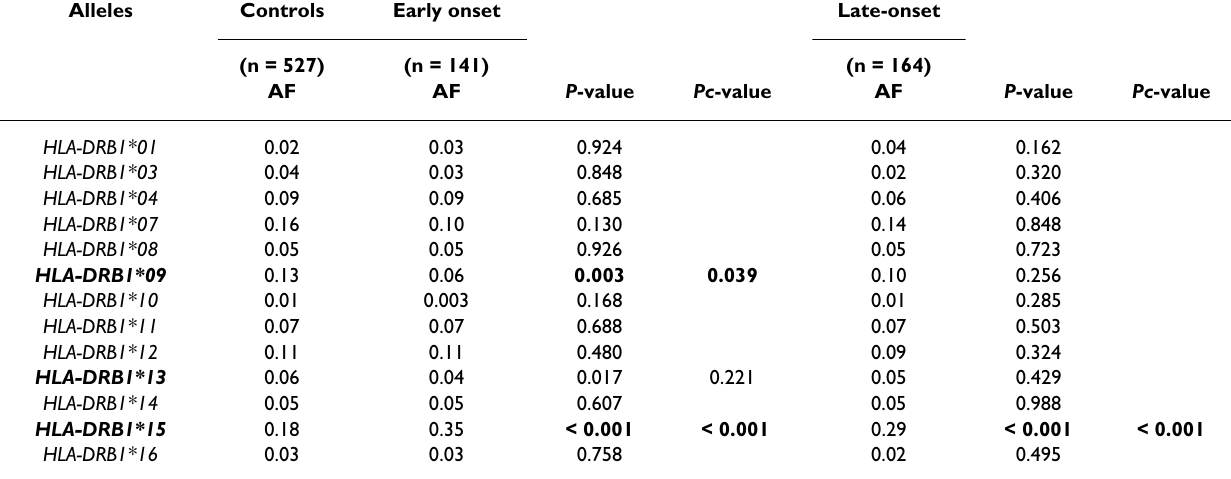
Table 3: Allele frequency distribution of HLA-DRB1* in early versus late-onset leprosy groups